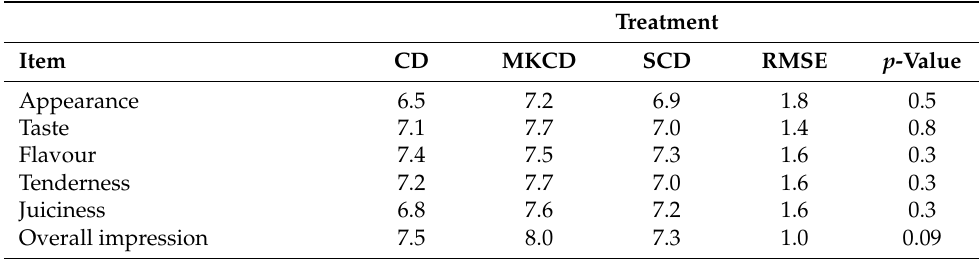
Table 9. Sensory evaluation of the Longissimus dorsi muscle from lambs.